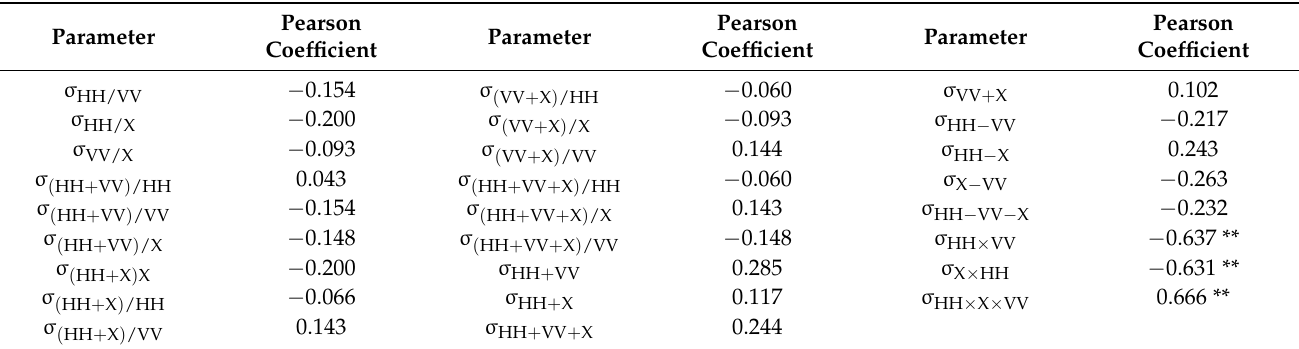
Figure 4. ( a ) Models established by σ HH and AGB; ( b ) models established by σ X and AGB; ( c ) models established by σ VV and AGB. Table 4. AGB backscatter coefficients correlation